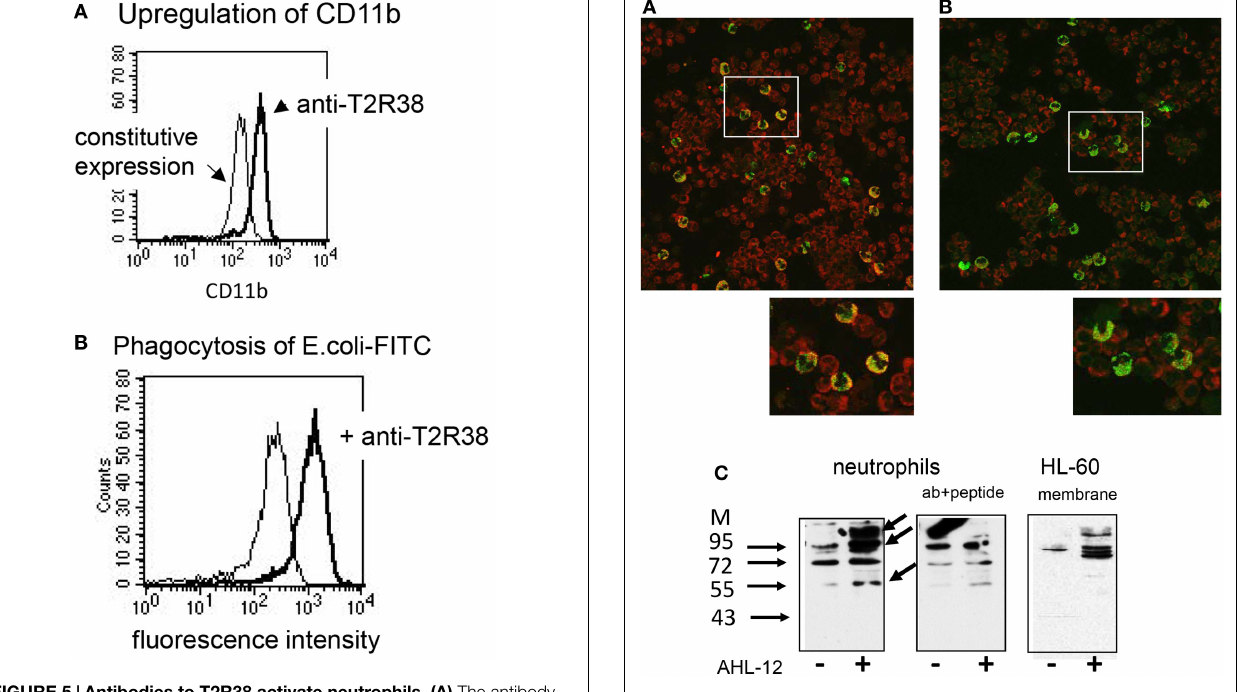
FIGURE 5 | Antibodies to T2R38 activate neutrophils . (A) The antibody sc-34294-induced up-regulation of CD11b on neutrophils (thick line; the thin shows constitutive CD11b expression) and (B) it enhanced the phagocytosis of FITC-labeled bacteria, measured as increase of cell-associated fluorescence intensity (thick line; the thin line shows phagocytosis in presence of the isotype IgG).